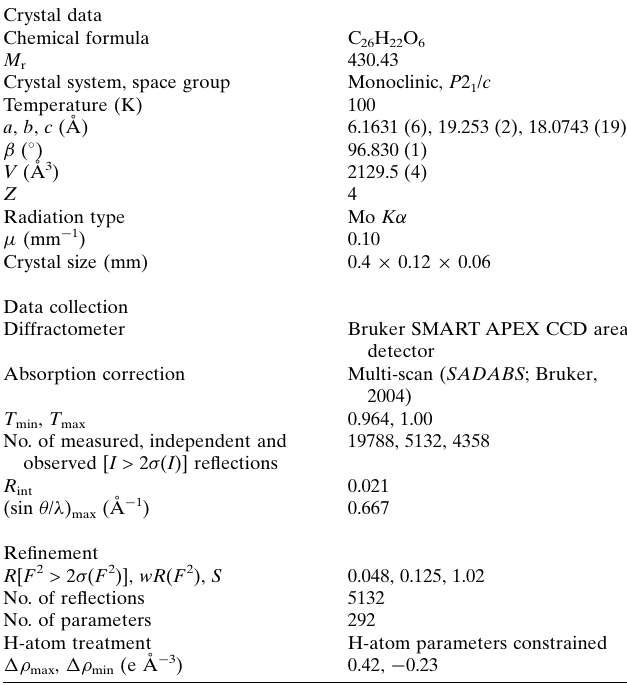
Crystal data Chemical